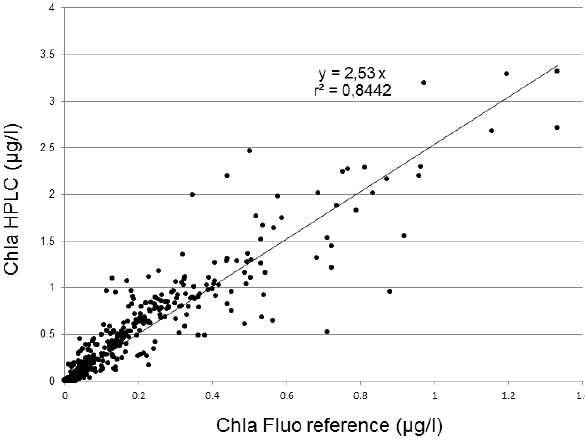
Figure 3. Relationship between the chl a concentration provided by the reference fluorometer and the chl a concentration estimated from HPLC measurements. This relationship was estimated over 70 test profiles ranging between 30 to 200m and performed between 2002 and